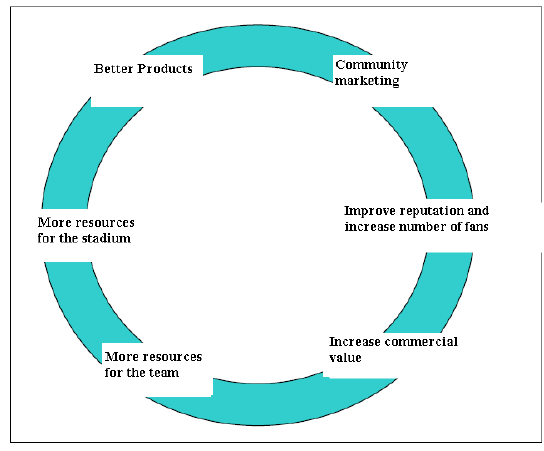
Figure 3 : The Virtuous